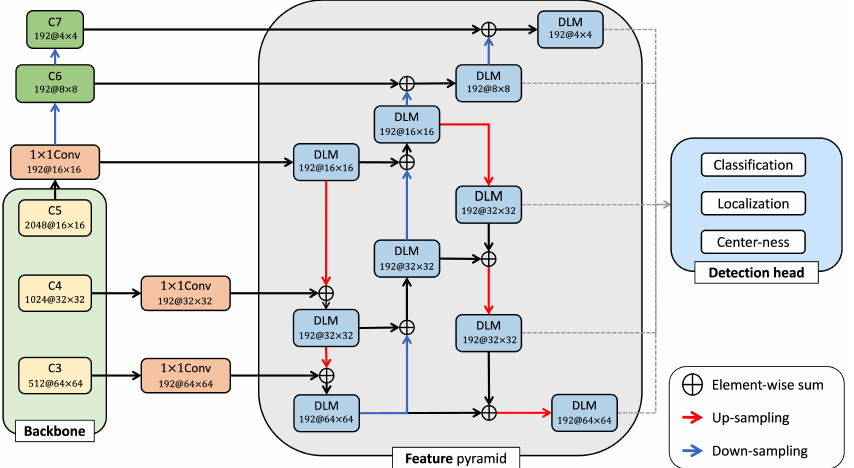
Figure 4. Proposed dual-path lightweight module (DLM) feature pyramid structure. Conv: